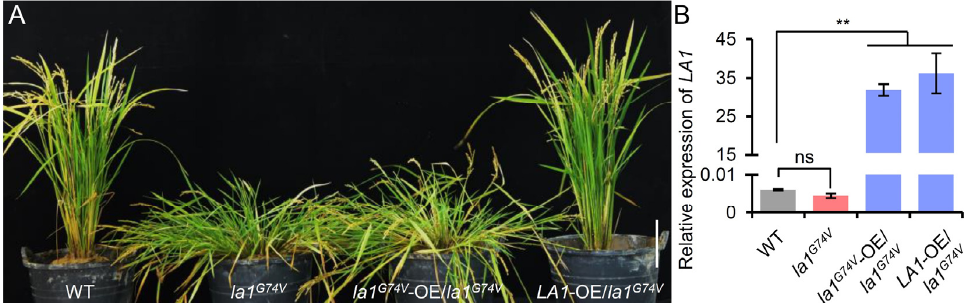
Figure 2. Genetic complementation of LA1 . ( A ) Plant architectures of WT, la1 G74V , and transgenic la1 G74V plants overexpressing LA1 or la1 G74V . Scale bar, 10 cm. ( B ) Comparison of LA1 expression in WT, la1 G74V , and transgenic la1 G74V plants overexpressing LA1 or la1 G74V via qRT-PCR. UFC1 served